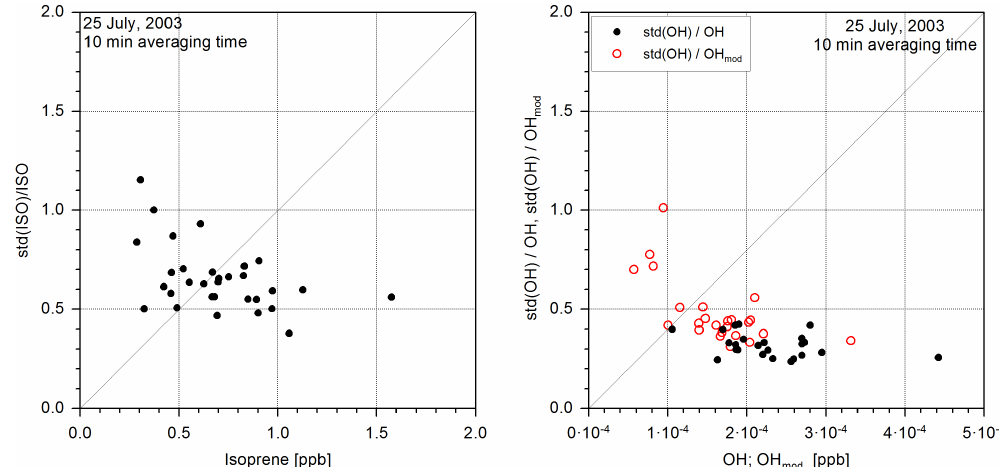
Figure 6. The normalised standard deviations of isoprene and OH (OH mod ) vs. their mixing ratios.